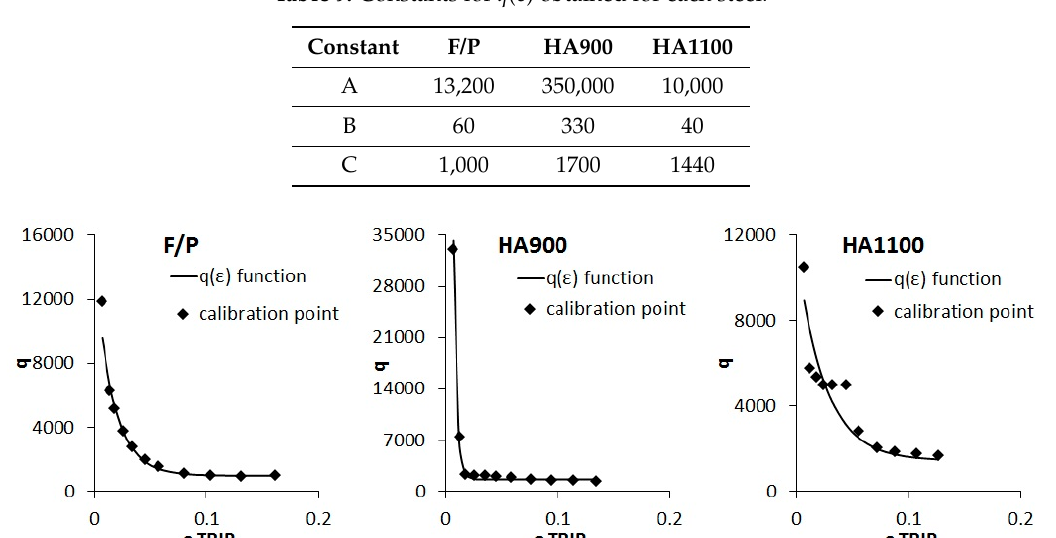
Figure 9. Stress-strain partition coefficient q( ε ) functions proposed for each